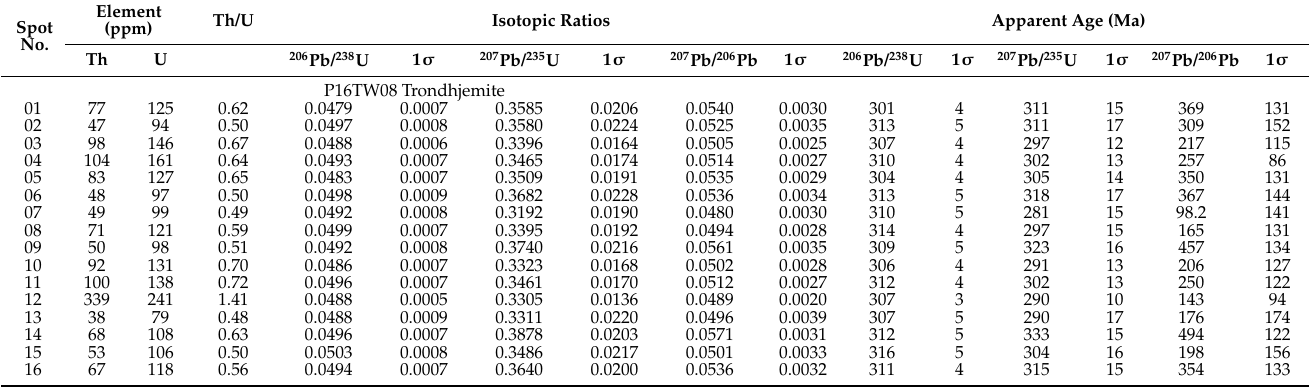
Table 2. LA-ICP-MS zircon U-Pb isotopic analysis of the Gaolihan